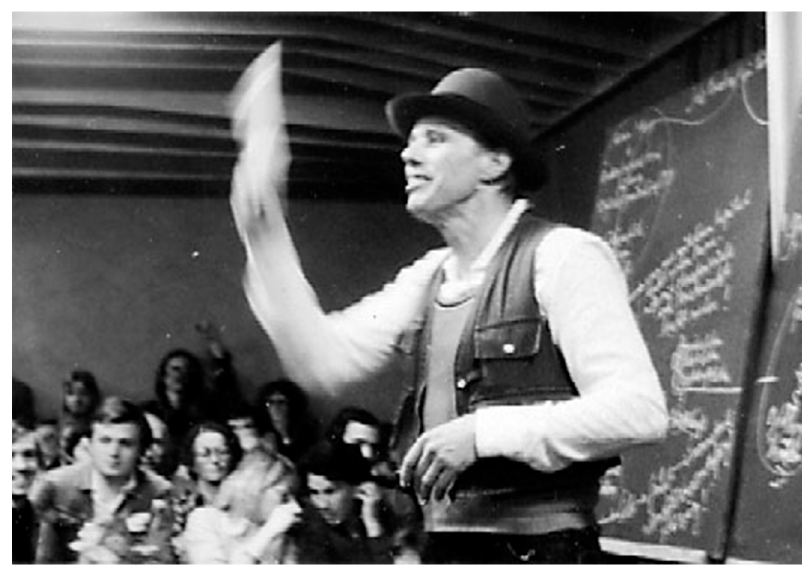
Figure 4. Joseph Beuys on his lecture “ Jeder Mensch ein Künstler—Auf dem Weg zur Freiheitsgestalt des sozialen Organismus ”. Behind him, the outcomes of the discussion are being fixed on a blackboard [57].